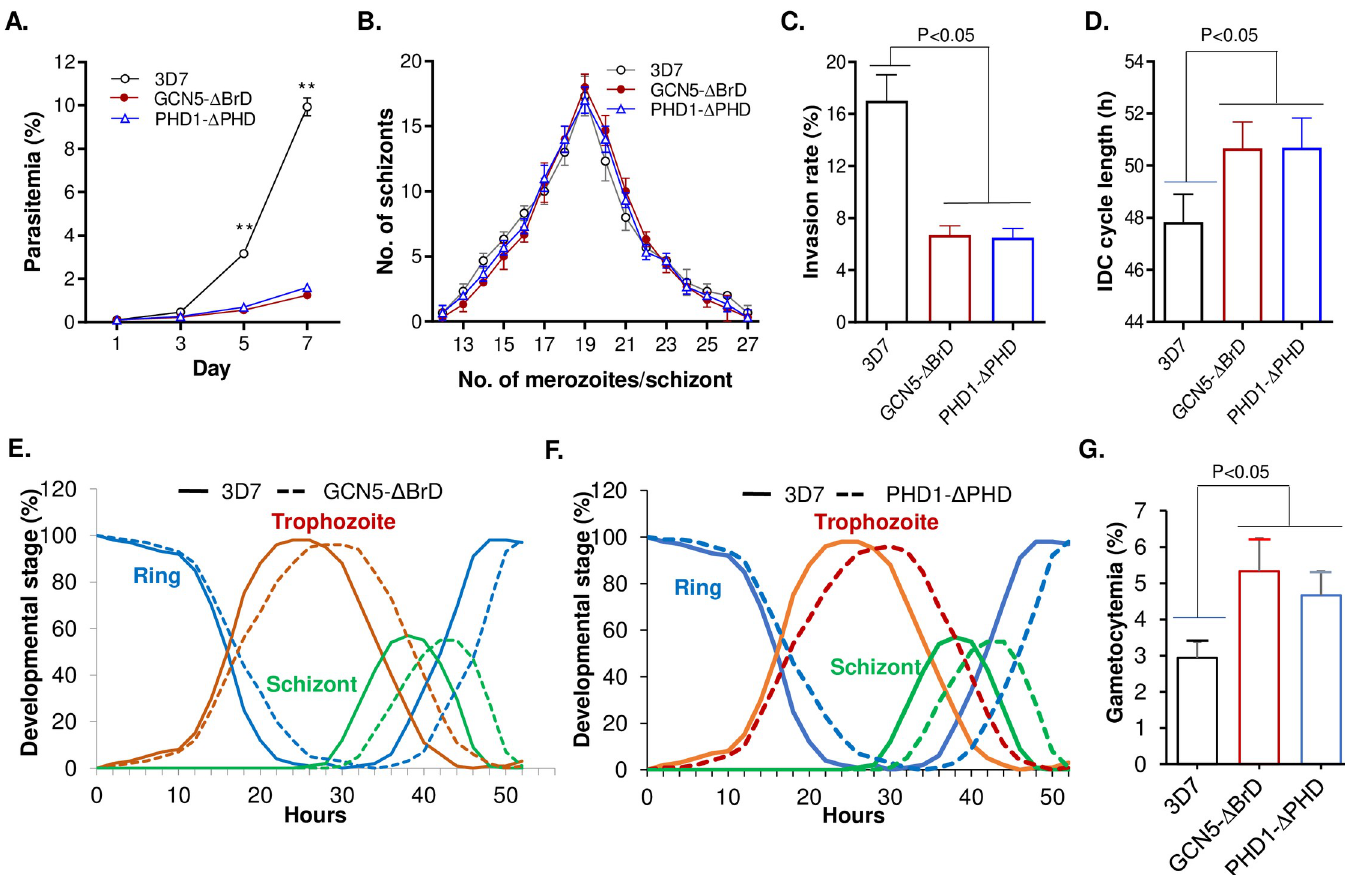
Fig 2. Growth phenotypes in PfGCN5 and PfPHD1 domain deletion mutants. (A) Asexual growth rates of WT 3D7, PfGCN5- Δ BrD::GFP, and PfPHD1- Δ PHD::GFP. �� indicate P < 0.01 (ANOVA) at days 5 and 7. The starting parasitemia was 0.1%. (B) The distribution of the number of mature schizonts with a variable number of merozoite. No differences were identified among the three parasite lines ( P > 0.05, ANOVA). (C) Invasion rates of the GCN5- Δ BrD::GFP and PHD1- Δ PHD::GFP parasite lines estimated by incubating purified schizonts with RBCs ( P < 0.05, paired Wilcoxon test). (D) The duration of the IDC showing significantly increased lengths in GCN5- Δ BrD::GFP and PHD1- Δ PHD::GFP parasite lines ( P < 0.05, paired Wilcoxon test). (E, F) Detailed analysis of the IDC showing extended ring stage in the GCN5- Δ BrD::GFP (E) and PHD1- Δ PHD::GFP (F). (G) Gametocytemias at day 6 after induction of gametocytogenesis showing significantly increased gametocytemia in the two domain deletion mutants ( P < 0.05, paired Wilcoxon